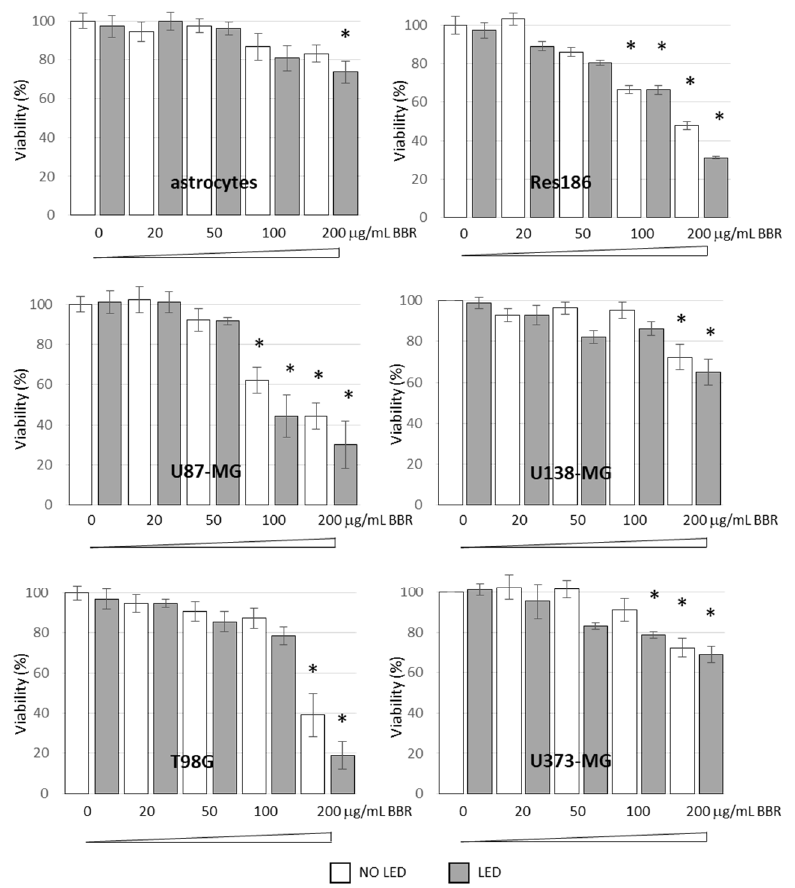
Figure 4. Cell Viability Assays after BBR and/or PDT (LED) administration. Normal rat astrocytes, low- (i.e., Res186) and high-grade (U87-MG, T98G, U373-MG. and U138-MG) astrocytoma cell lines were treated with different concentrations of BBR (0, 20, 50, 100, 200 μ g/mL for 4 h, white bars) and exposed to LED stimulation for 4 min (grey bars). Colorimetric MTS analysis was carried out after 24 h p.t. All experiments were performed in triplicates with independent assays. Asterisks indicated statistical significance compared to untreated cells ( p < 0.05, Anova One-way).